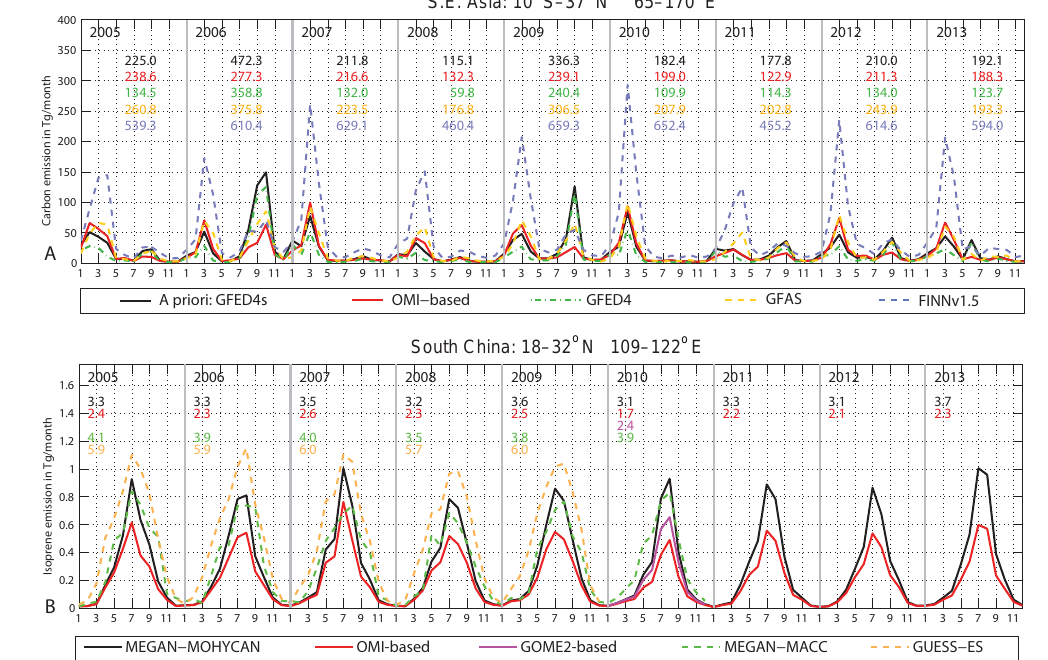
Figure 13. As Fig. 9 but for southeast Asia.